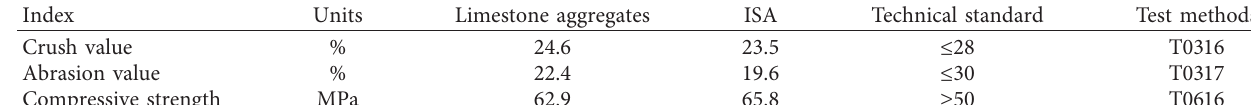
Table 6: Comparison of physical properties between ISA and traditional limestone